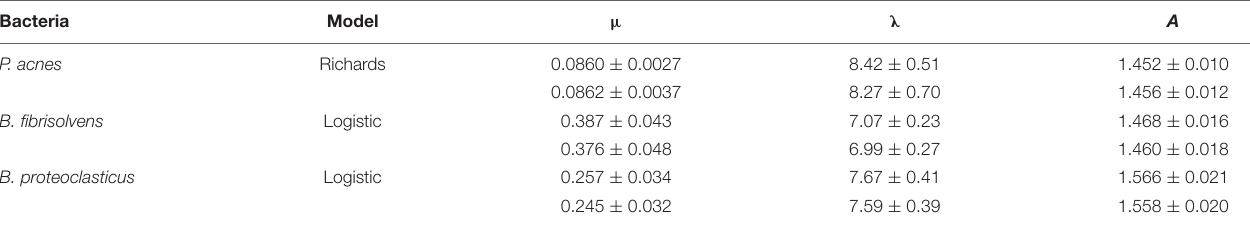
TABLE 3 | Parameters of the growth curves Propionibacterium acnes , Butyrivibrio fibrisolvens , Butyrivibrio proteoclasticus , obtained using the miniaturized setup. Bacteria